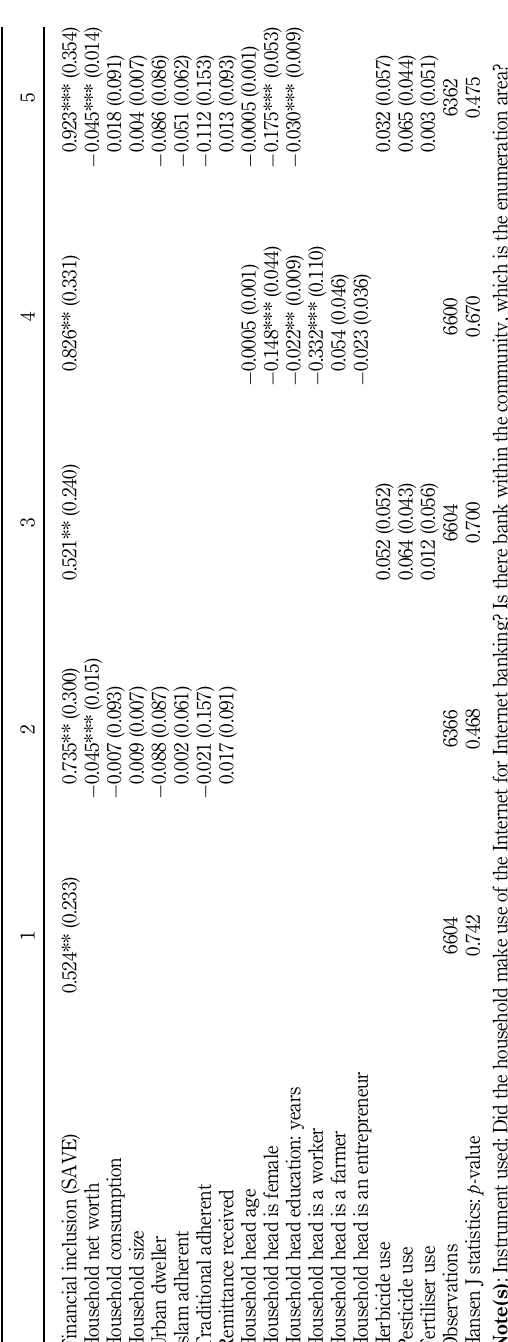
Table 3. Effects of